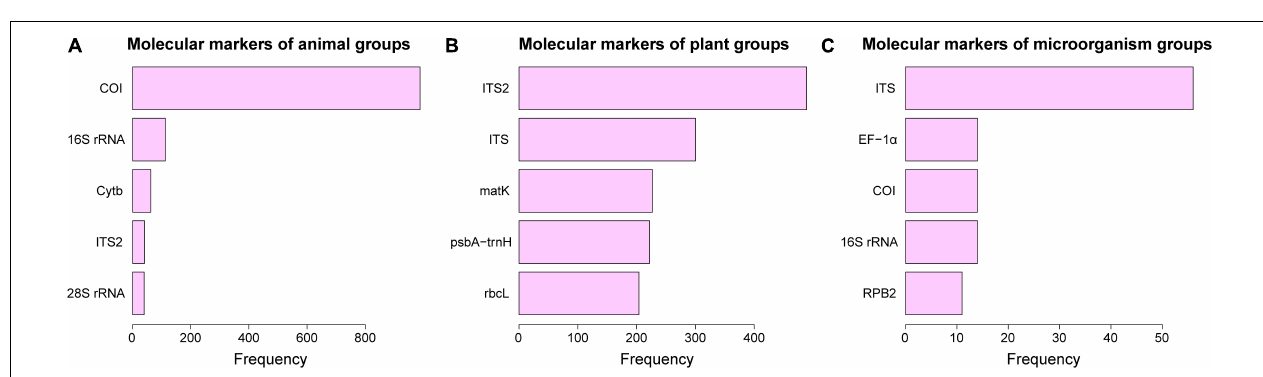
FIGURE 8 | Frequency of DNA barcodes articles pertaining to animals, plants, and microorganisms. (A) animal, (B) plant, and (C) microorganism groups. The X axis represents the frequency of each molecular marker used in the article, and the Y axis represents the name of the gene used as a molecular marker.